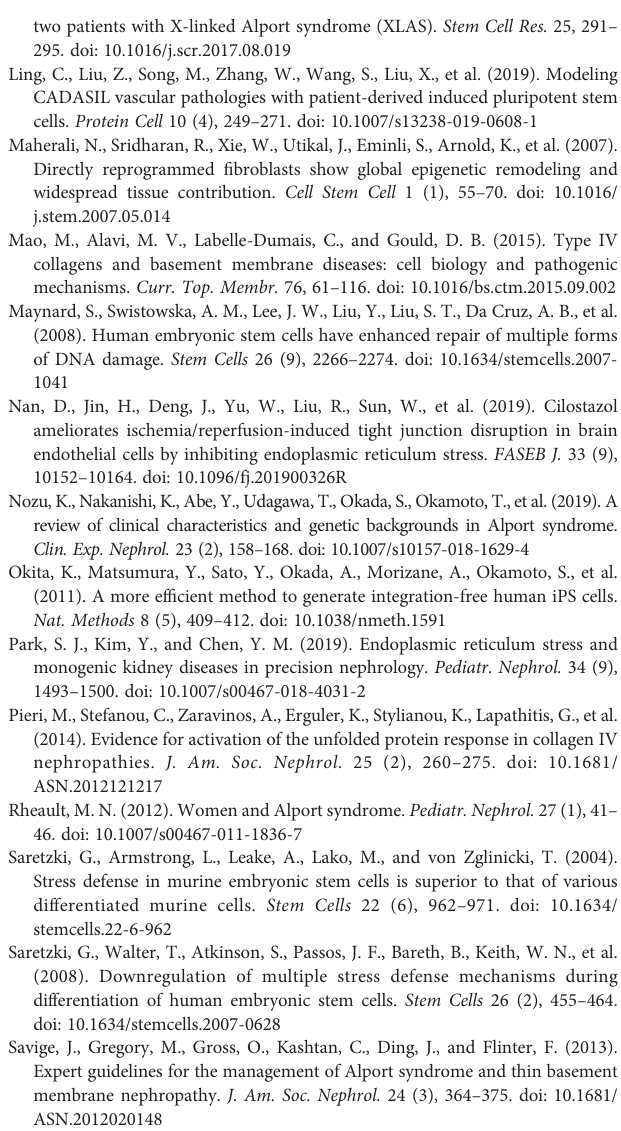
SUPPLEMENTARY FIGURE 1 | The full scan of the original gels of blots shown in Figure 3 . SUPPLEMENTARY FIGURE 2 | The full scan of the original gels of blots shown in Figure 4